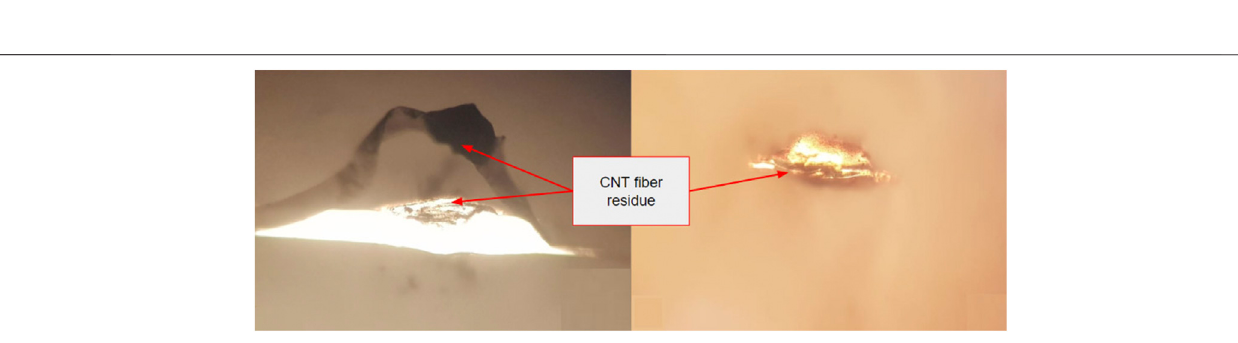
FIGURE 9 | Optical microscope images of the separator from failed test cells showing CNT fi ber residue on the puncture hole.